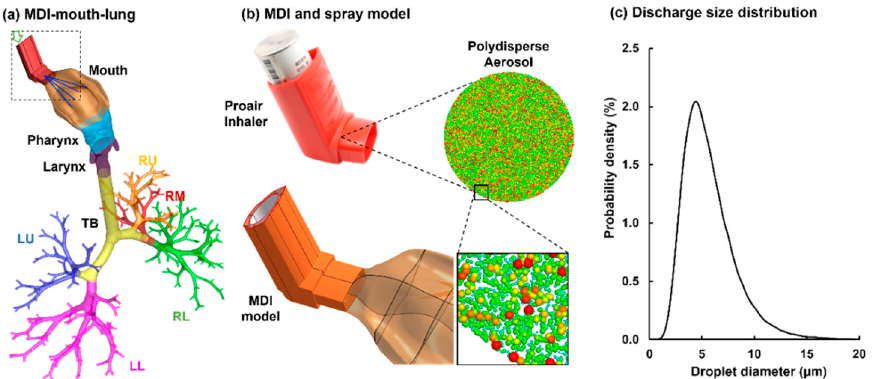
Figure 1. MDI delivery computational model: ( a ) an integrated MDI-mouth-lung model geometry that extends to G9, ( b ) the MDI model for ProAir-HFA and polydisperse aerosols discharged from the MDI orifice, and ( c ) the droplet size distribution typical of the ProAir-HFA inhaler.